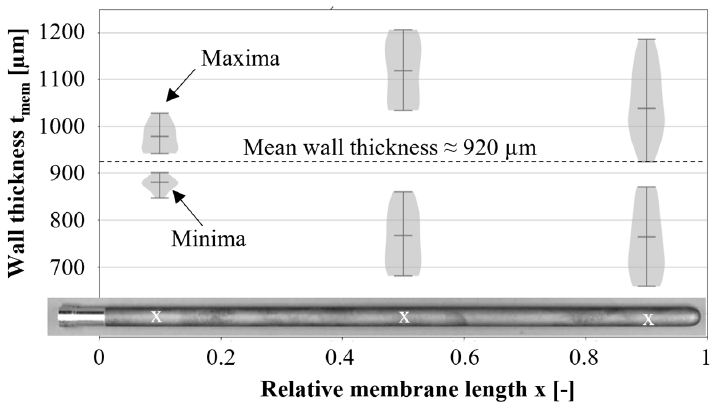
Figure 1. Non-destructively measured distribution of minimum and maximum wall thickness of membrane tubes. X indicates the measuring position.